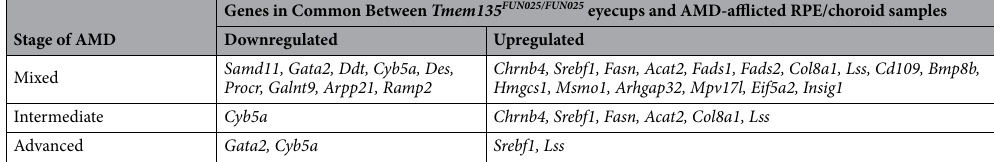
Table 2. Summary of significantly-affected genes in common between Tmem135 FUN025/FUN025 versus WT eyecup RNAseq and GSE29801 and GSE135092